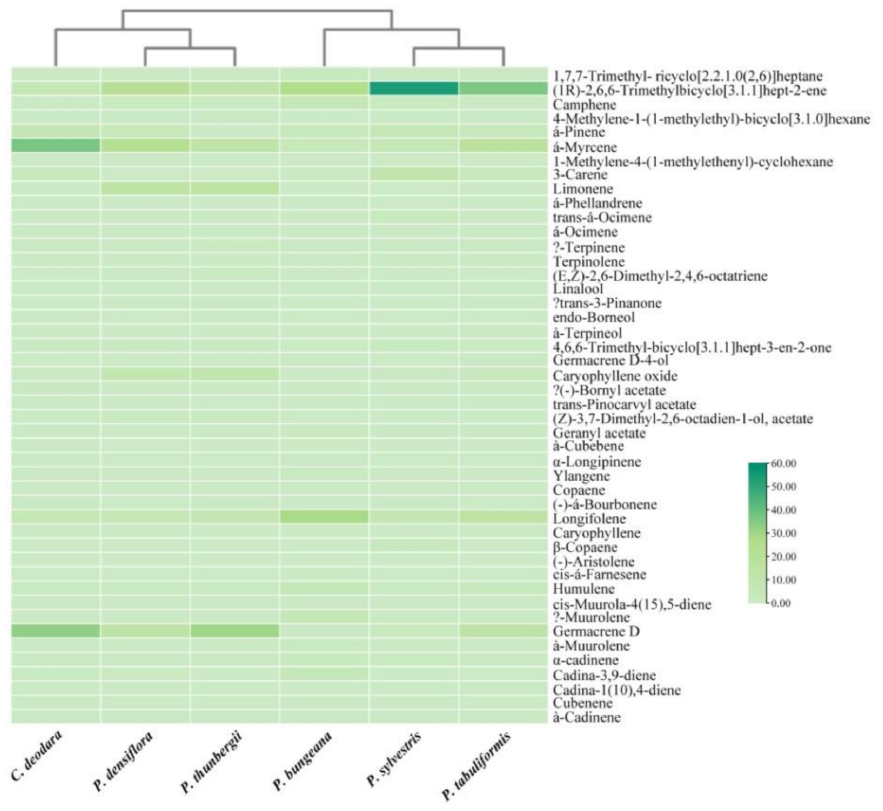
Figure 4. Cluster pedigree diagram of volatile terpenes and terpenoids in the pine leaf